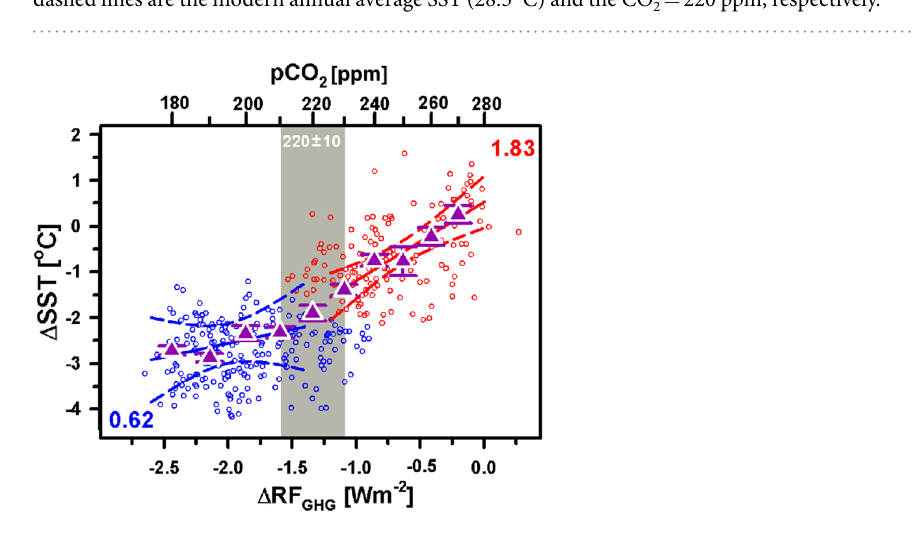
Figure 3. Nonlinearity of SST sensitivity to climate in the southern WPWP. The Solomon Δ SST and greenhouse gas radiative forcing Δ RF GHG data are plotted at a 1-kyr interval. Two groups (blue and red circles) were divided at a pCO 2 level of 220 ppm via cluster analysis (see Methods). Purple triangles are standard deviations of the mean for Δ SST data points at a segment of radiative forcing corresponding to 10 ppm pCO 2 . Solid and dashed lines for each group represent the regression line and 95% confidence interval, respectively. The determined slopes are given as lines. The gray vertical bar marks the significant difference threshold for the non-linear SST changes at a pCO 2 level of 220 ± 10